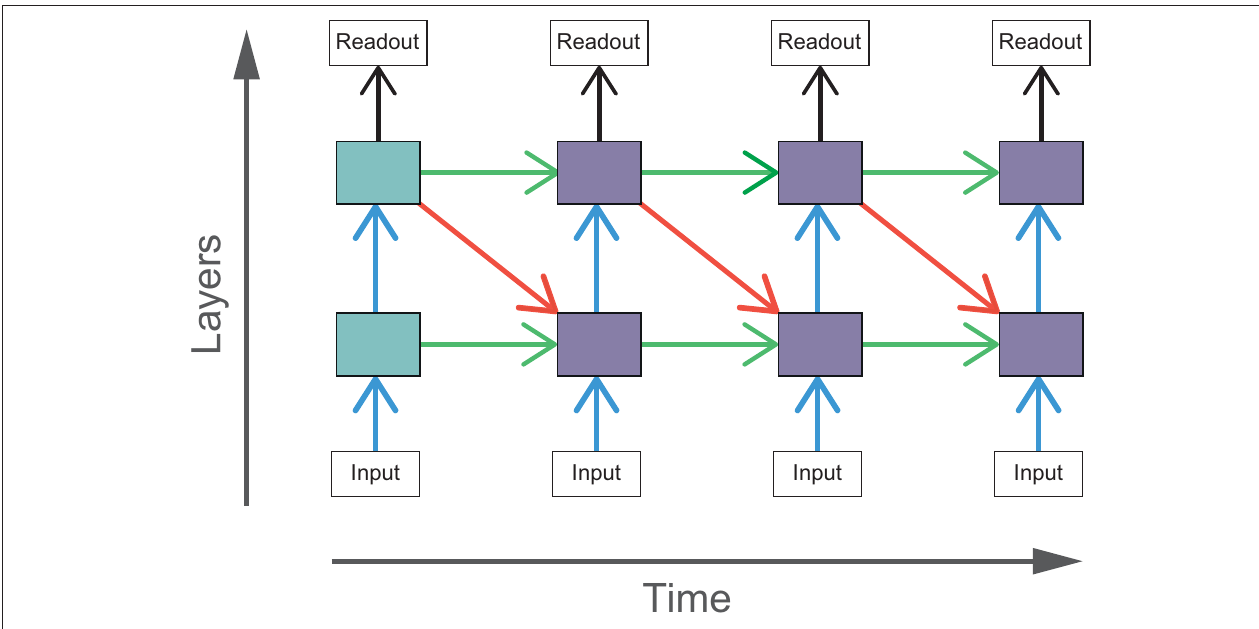
FIGURE 4 | The computational graph of BLT unrolled over four time steps. The shaded boxes indicate hidden layers that receive purely feedforward input (blue) and those that receive both feedforward and recurrent input (purple).